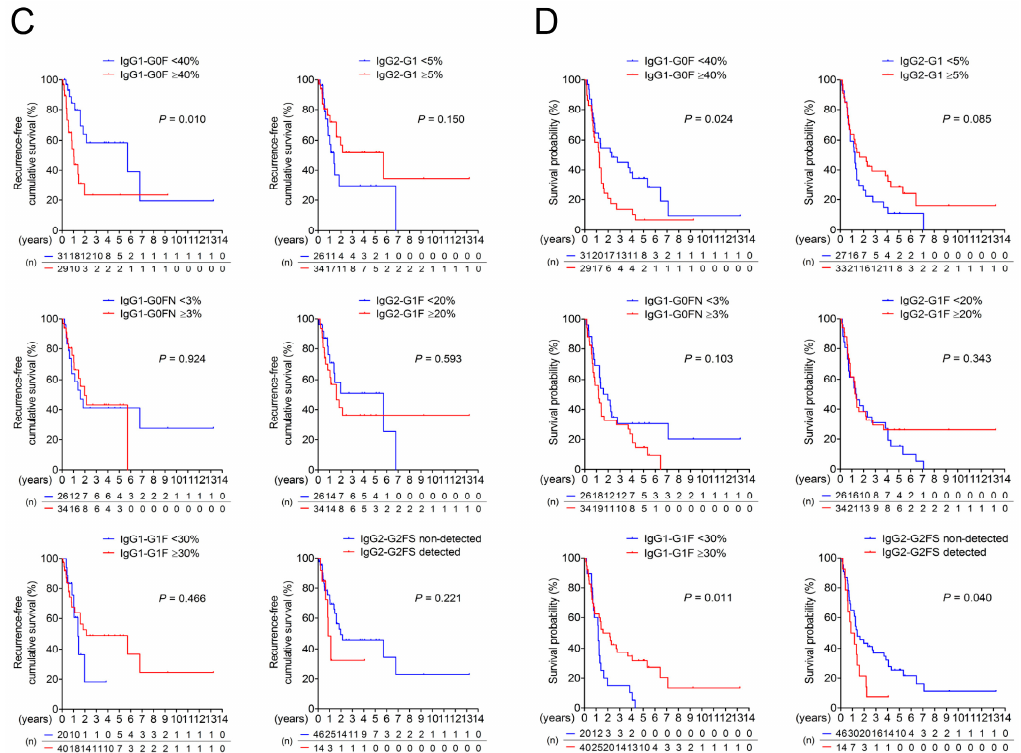
Figure 1. Association of IgG glycoforms and cholangiocarcinoma differentiation, metastasis, recurrence, and survivals. Levels of IgG 1 -G0F, IgG 1 -G0FN, IgG 1 -G1F, IgG 2 -G1, IgG 2 -G1F, and IgG 2 -G2FS ( A ) in different tumor grades and ( B ) with or without tumor metastasis are shown in Tukey box-and-whisker plots. p -values in ( A ) and ( B ) are obtained from Kruskal–Wallis tests and Mann–Whitney U tests, respectively. Kaplan–Meier analyses of ( C ) recurrence-free survivals and ( D ) overall survivals in patients with different levels of IgG 1 -G0F, IgG 1 -G0FN, IgG 1 -G1F, IgG 2 -G1, IgG 2 -G1F, and IgG 2 -G2FS are shown. p -values are obtained from log-rank tests. Abbreviations: F, fucosylated; G0, agalactosylated; G1, partially galactosylated; G2, fully galactosylated; N, bisected N -acetylglucosamine; S, sialylated.